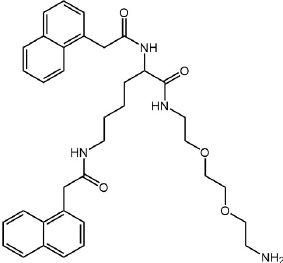
Figure 4. Chemical structure of the amphiphilic gelator derived from lysine.